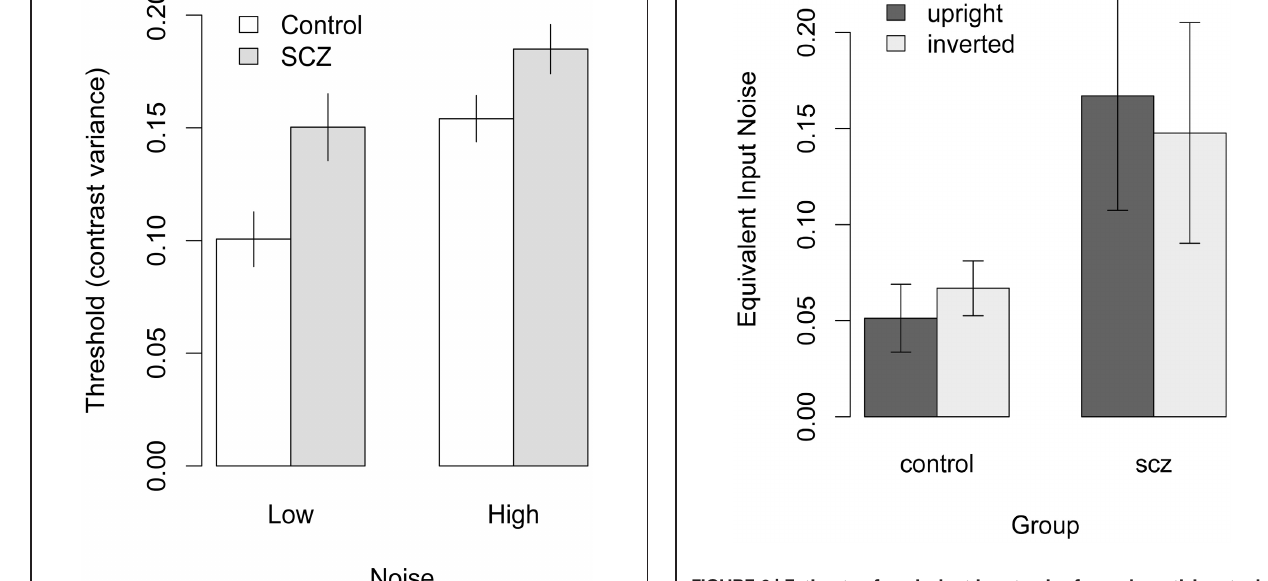
FIGURE 6 | Estimate of equivalent input noise for each participant who had a higher threshold in the high-noise condition. For healthy controls equivalent input noise was slightly higher with inverted faces, but in the SCZ group it was slightly lower with inverted faces. One-tailed t -tests performed on log-transformed data indicated that the group difference was significant in the upright face condition. Error bars represent ± 1 standard